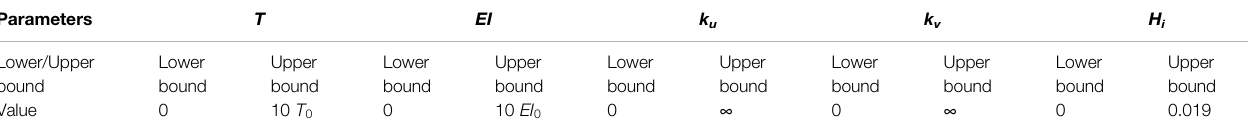
TABLE 7 | Solution range when solving optimization problem ( T 0 : tension measured by load cell in Table 5C ; EI 0 : design value in catalog listed in Table 5A ). Parameters T EI k u k v H i Lower/Upper